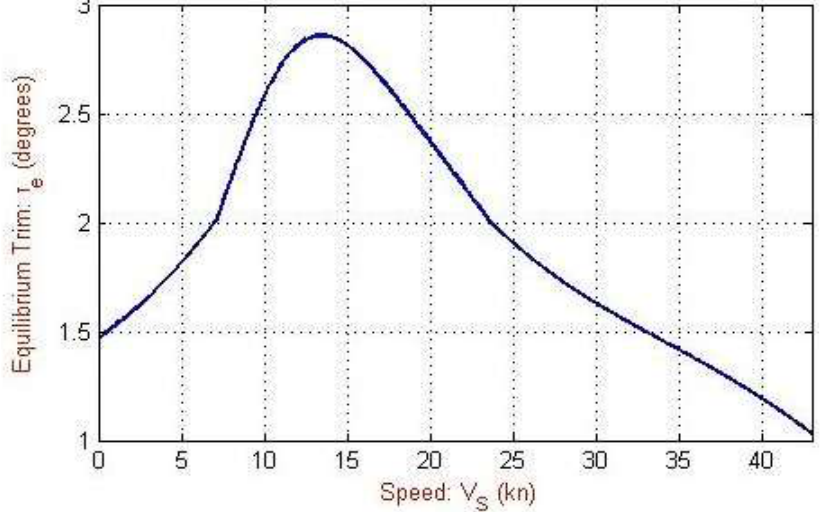
Figure 16. Equilibrium trim versus speed, according to the Savitsky general case method.